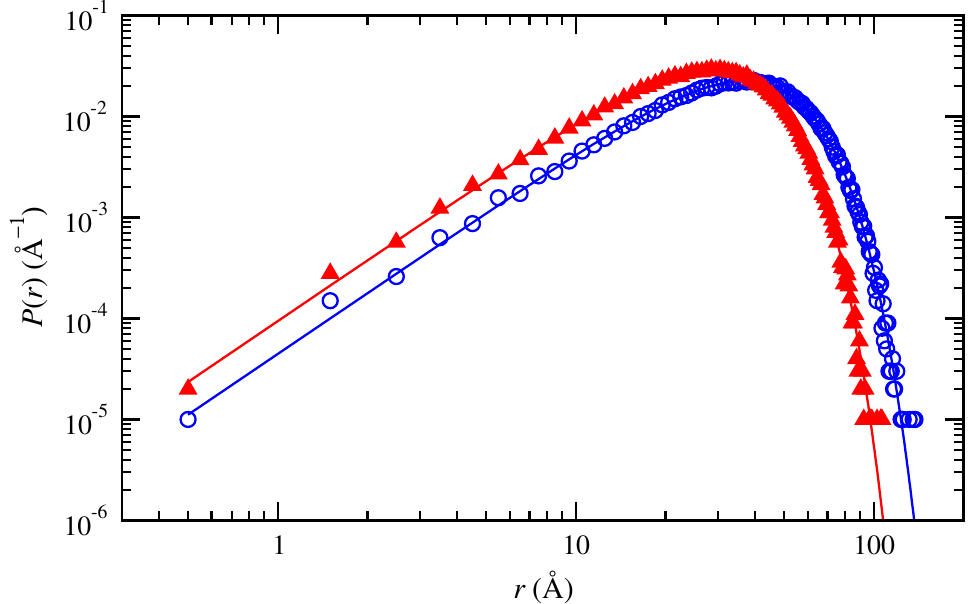
Figure 1. Probability density distributions of end-to-end distance obtained numerically for Gaussian chains of ( ◦ , blue) trans-1,4-polybutadiene and ( (cid:78) , red) cis-1,4-polybutadiene at 343 K with 50 repeat units. Lines indicate the analytic Gaussian probability density distribution